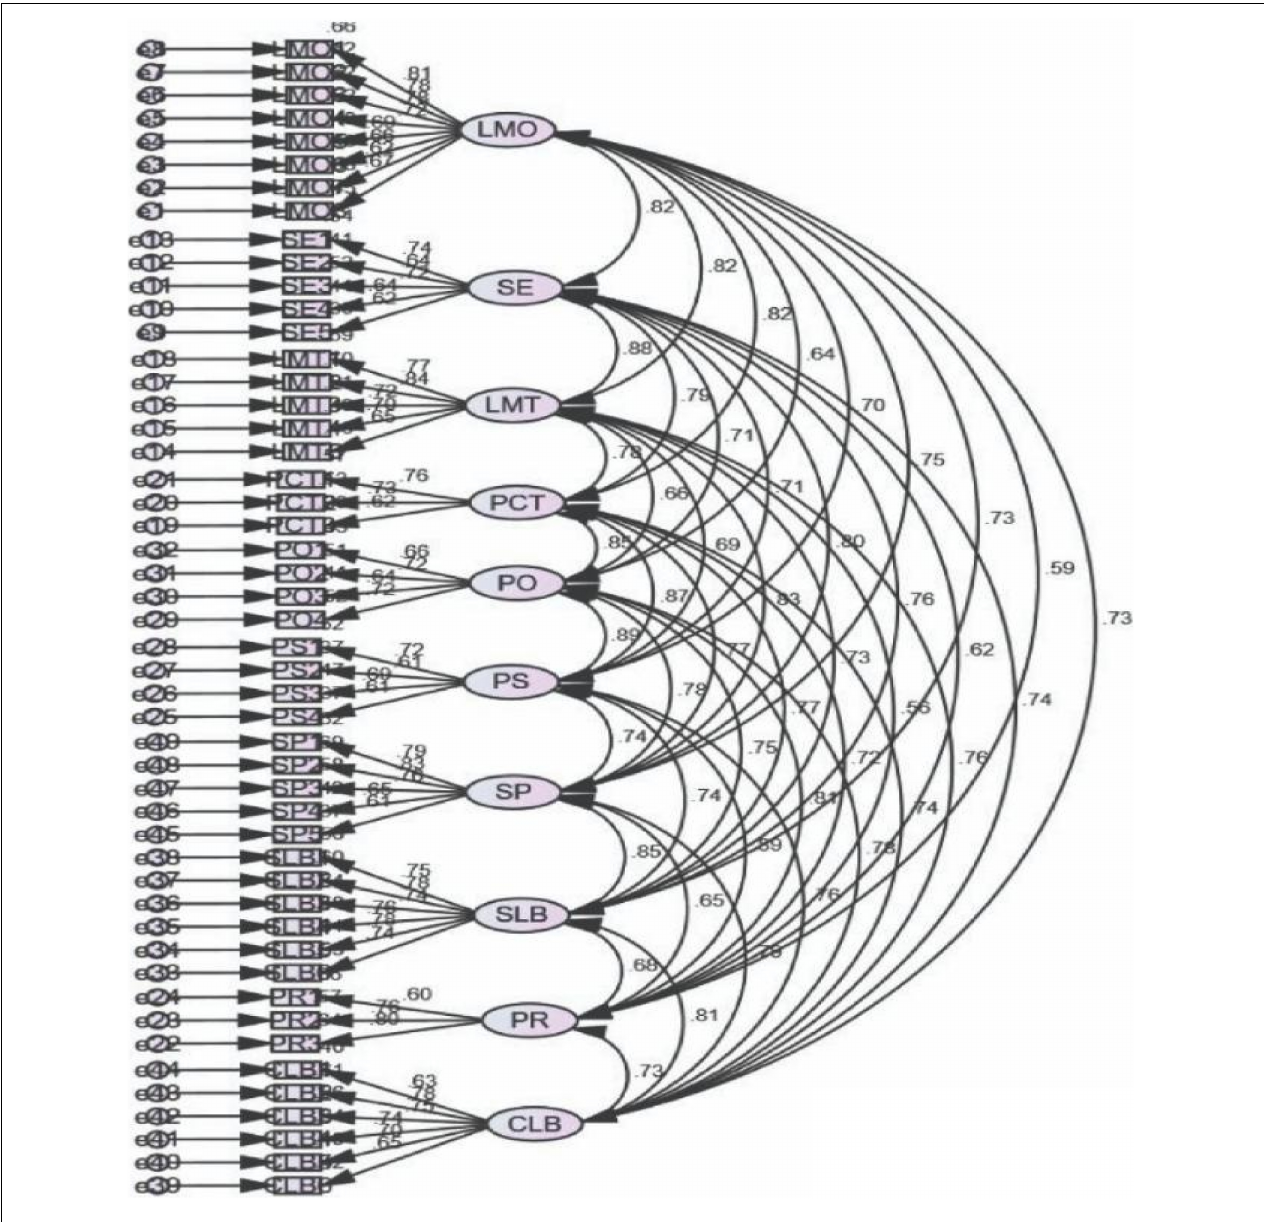
FIGURE 2 | First-order-factor-analysis of all